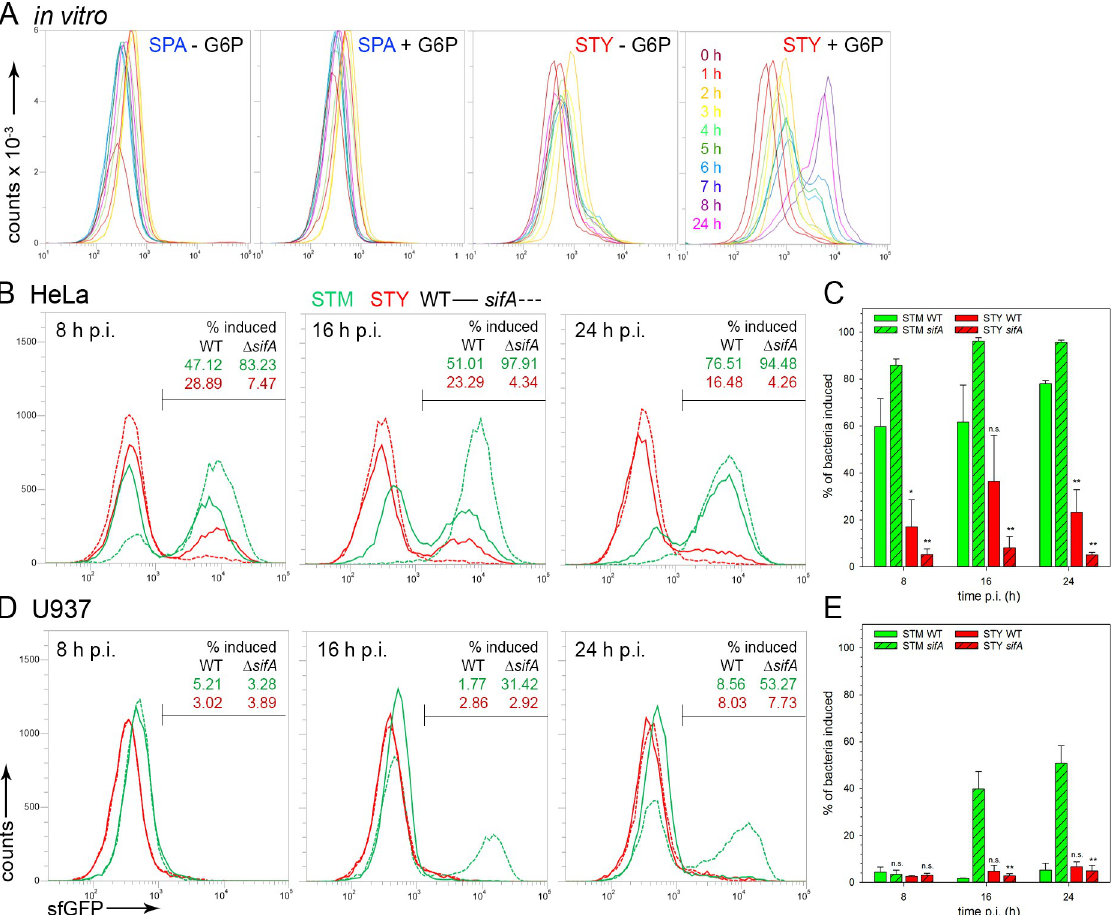
Fig 6. SCV integrity and cytosolic release of STM and STY. STM (green), SPA (blue), or STY (red), WT (solid lines) or Δ sifA (dashed lines) strains were used as indicated, each harboring plasmid p4889 for constitutive expression of DsRed, and P uhpT -controlled expression of sfGFP as sensor for cytosolic exposure. A) Induction of P ::sfGFP by glucose-6-phosphate (G6P) in SPA and STY. SPA or STY WT uhpT harboring p4889 were grown in LB broth without or with addition of 0.2% G6P. Samples were collected at various time points of subculture as indicated by various colors. Bacteria constitutively expressing DsRed were analyzed by FC for levels of sfGFP expression. B, D) WT (solid lines) or sifA mutant (dashed lines) strains of STM (green) or STY (red), each harboring plasmid p4889 were used to infect HeLa cells ( B ), or U937 macrophages without IFN- γ -activation ( D ). At 8 h, 16 h, or 24 h p.i. as indicated, host cells were lysed in order to release bacteria. For FC, at least 10,000 bacteria-sized particles with DsRed fluorescence were gated and the GFP intensity was quantified. The percentage of bacterial cells with induction of P uphT ::sfGFP is indicated for WT and sifA mutant strains. The data sets shown in B) and D) are representative for three independent experiments with similar outcome. Cytosolic-induced Salmonella are expressed as percentage of entire intracellular Salmonella , means and standard deviations were determined for three independent experiments for infection of HeLa cells ( C ), or U937 cells ( E ). Statistical analysis was performed by One-way ANOVA and are indicated as follows: n.s., not significant; � , P < 0.05; �� , P < 0.01; ��� , P <